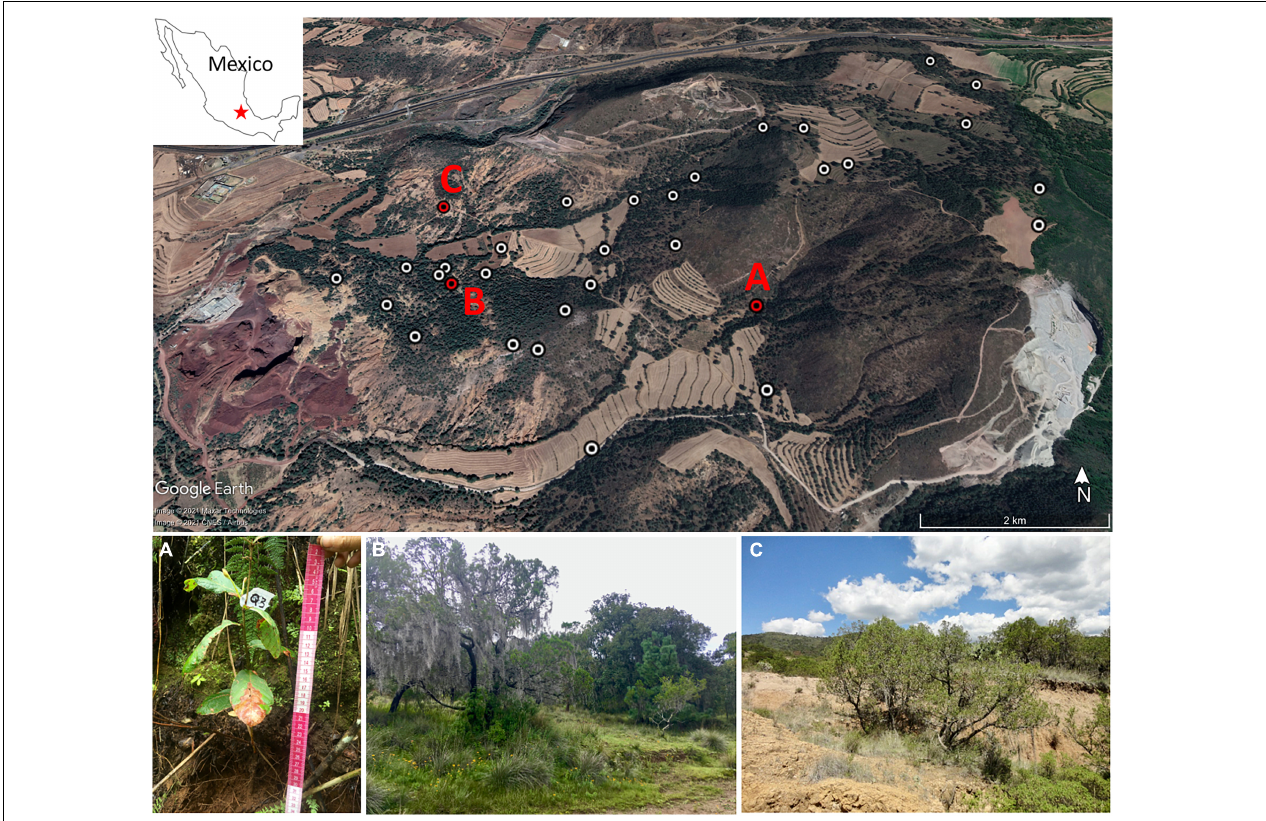
FIGURE 1 | Mining area of Basaltex (red star) in the state of Mexico, with the three study sites (red circles) selected from the vegetation survey plots (white circles). (A) Quercus rugosa seedling in the native forest dominated by Quercus and Pinus spp. ( Supplementary Table 1 ). (B) Mixed site in the transition zone, with Quercus rugosa and Juniperus deppeana sharing the tree layer with Arbutus xalapensis and Pinus teocote . (C) Juniperus deppeana growing spontaneously in the disturbed site with high soil